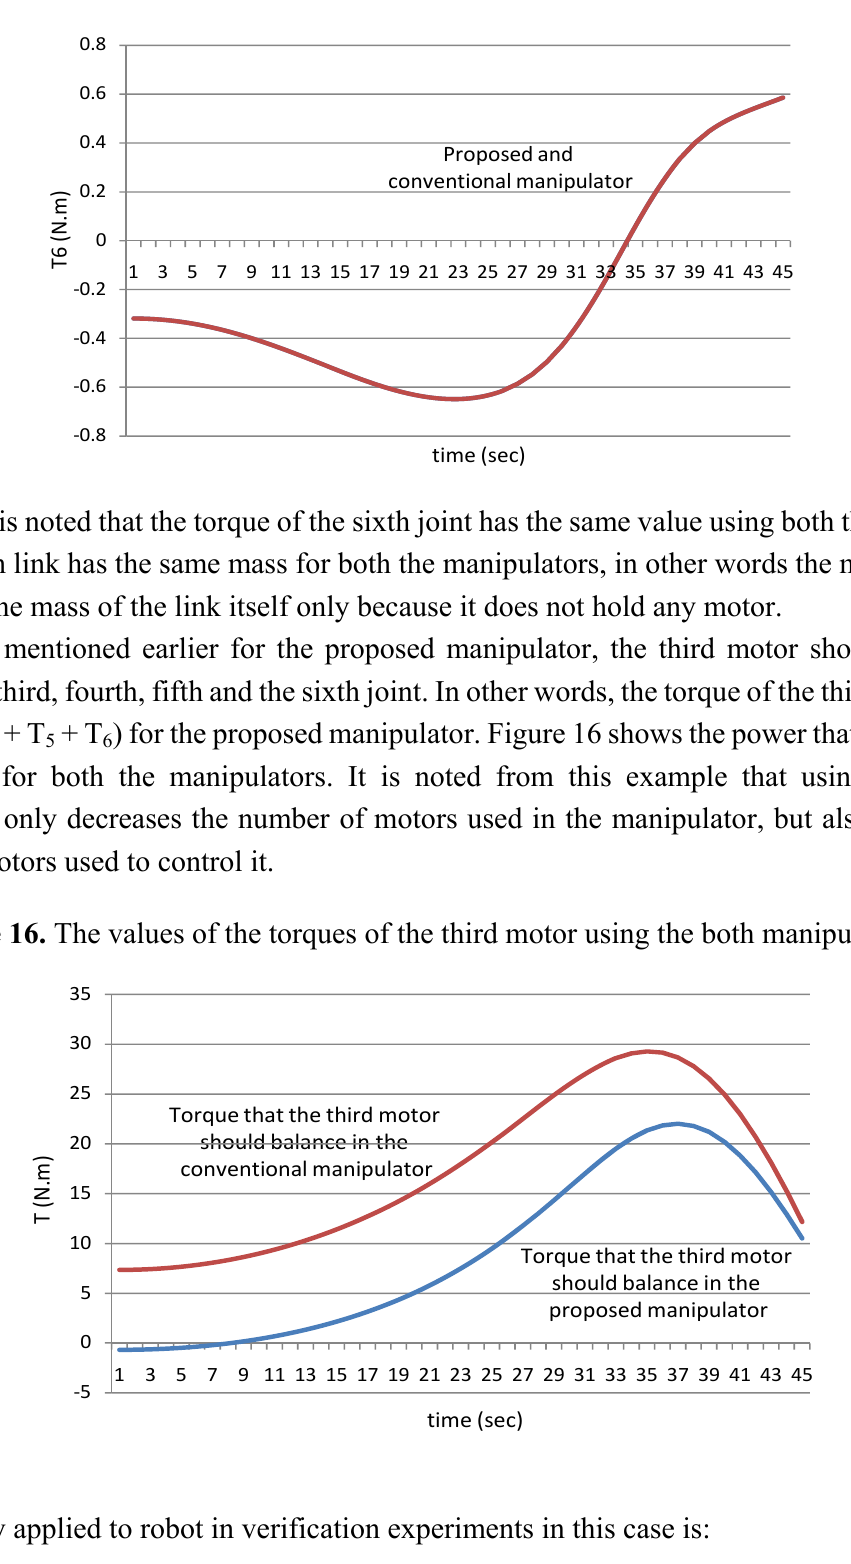
Figure 15. The values of the torques of the sixth joint using the both manipulators.